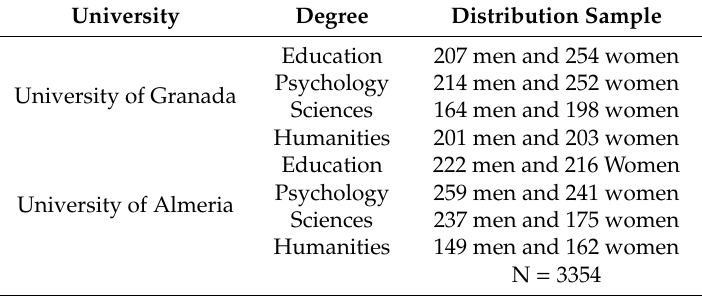
Table 1. Description of the